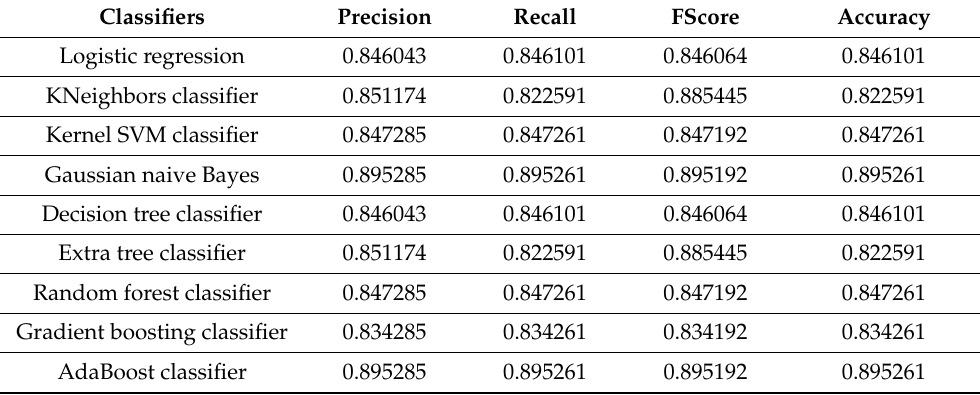
Table 9. AdaBoost regressor metrics before feature